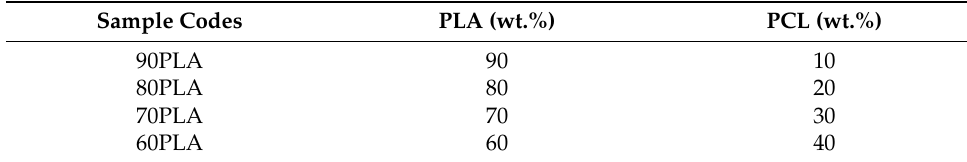
Table 1. Labels and composition of samples studied.